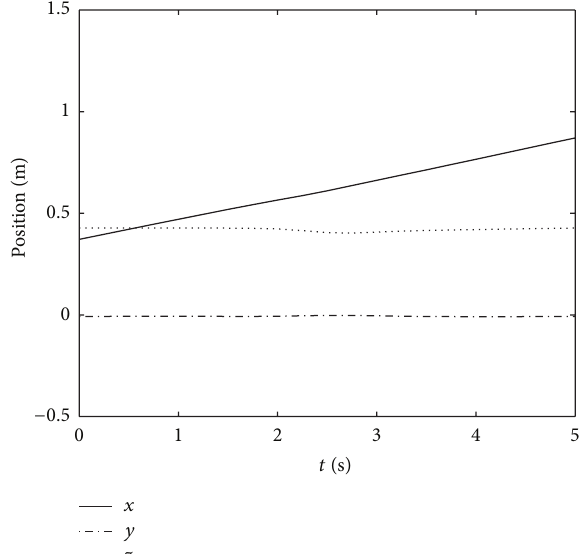
Figure 15: Closest distance.